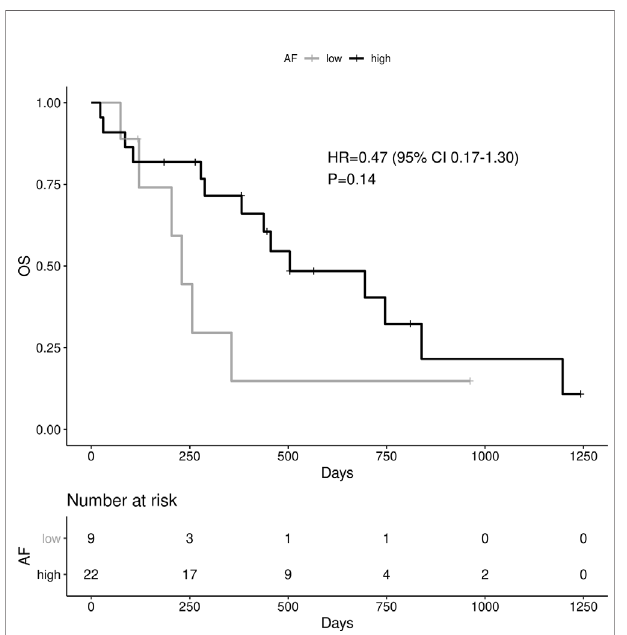
FIGURE 4 | Impact of tumor sensitivity on